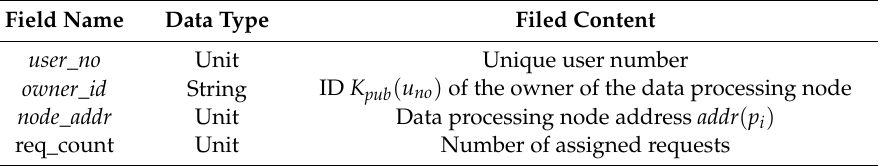
Table 4. Schema of data processing node database.